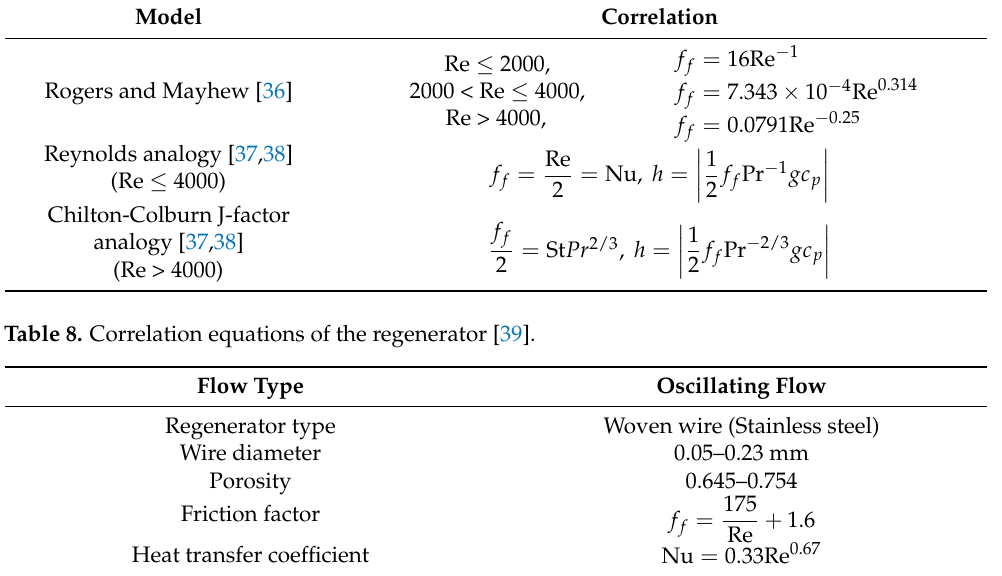
Table 7. Correlation equations of the heat exchanger.